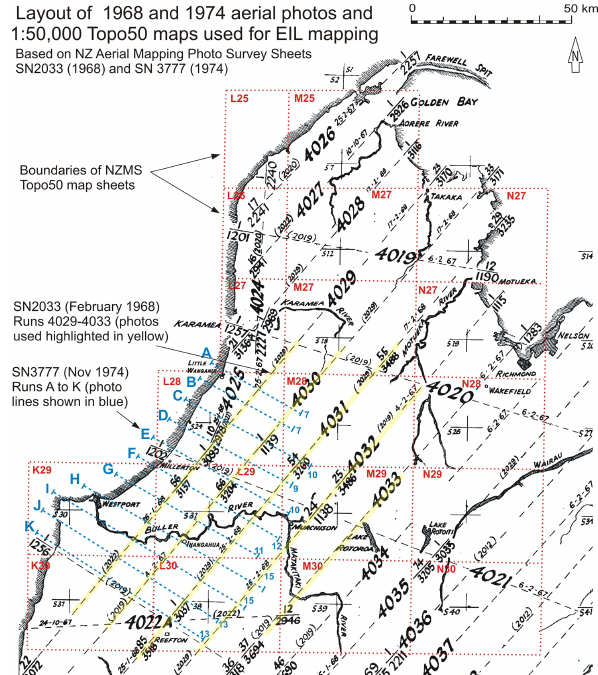
Figure A1. Map showing the layout and location of aerial photo surveys SN2033 and SN3777, aerial photo runs and areas of 1:50000 topographic maps used in the mapping of landslides caused by the 1929 and 1968 earthquake (Hancox et al.,